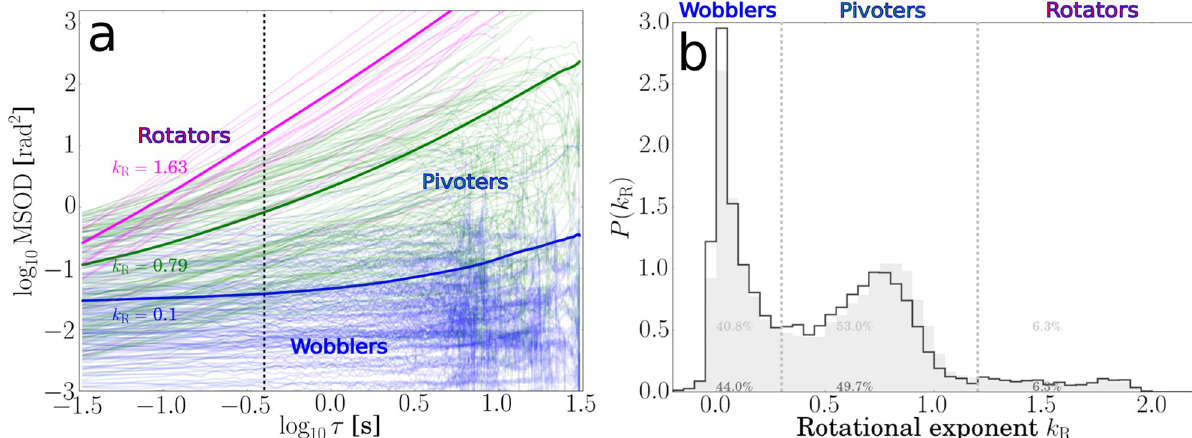
Fig 5. Calculation and distribution of rotational exponents used to identify different post-adhesion dynamics. (a) log-log plot of the MSOD versus delay time for adhering bacteria reveals different post-adhesion dynamics of cells: wobbling, pivoting or actively rotating. The slope gives the rotational exponent, the vertical dotted line marks the delay time τ = 0.4s. Thin lines represent data from individual trajectories. Thick lines represent averages for each category and are calculated from duration-weighted trajectories. (b) distribution of rotational exponents for adhering cells showing regions for wobbling, pivoting and rotating post-adhesion dynamics. The gray distributions represent exponents calculated for shorter delay times ( τ = 0.4s), black lines are distributions including exponents calculated for longer delay times ( τ = 4s).